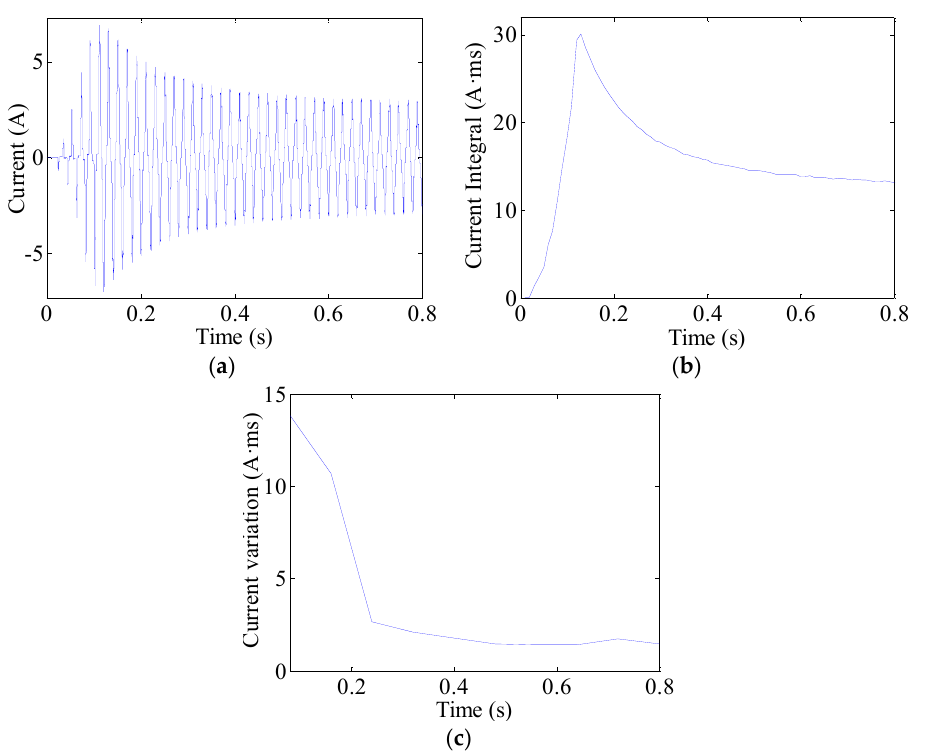
Figure 16. Transient process analysis of the electrical drill: ( a ) current waves; ( b ) current periodic integrals; ( c ) current variations.